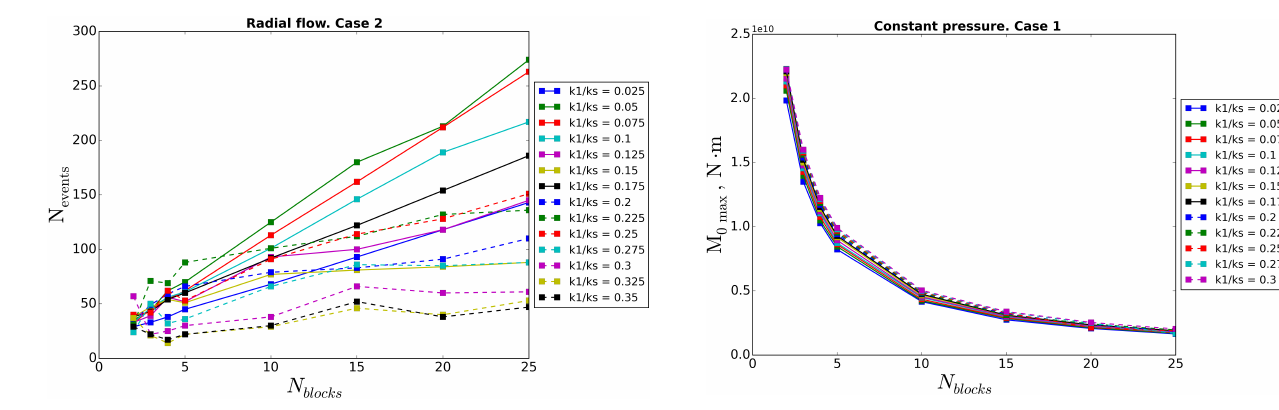
Figure 9. Maximum seismic moment of event vs. number of blocks.